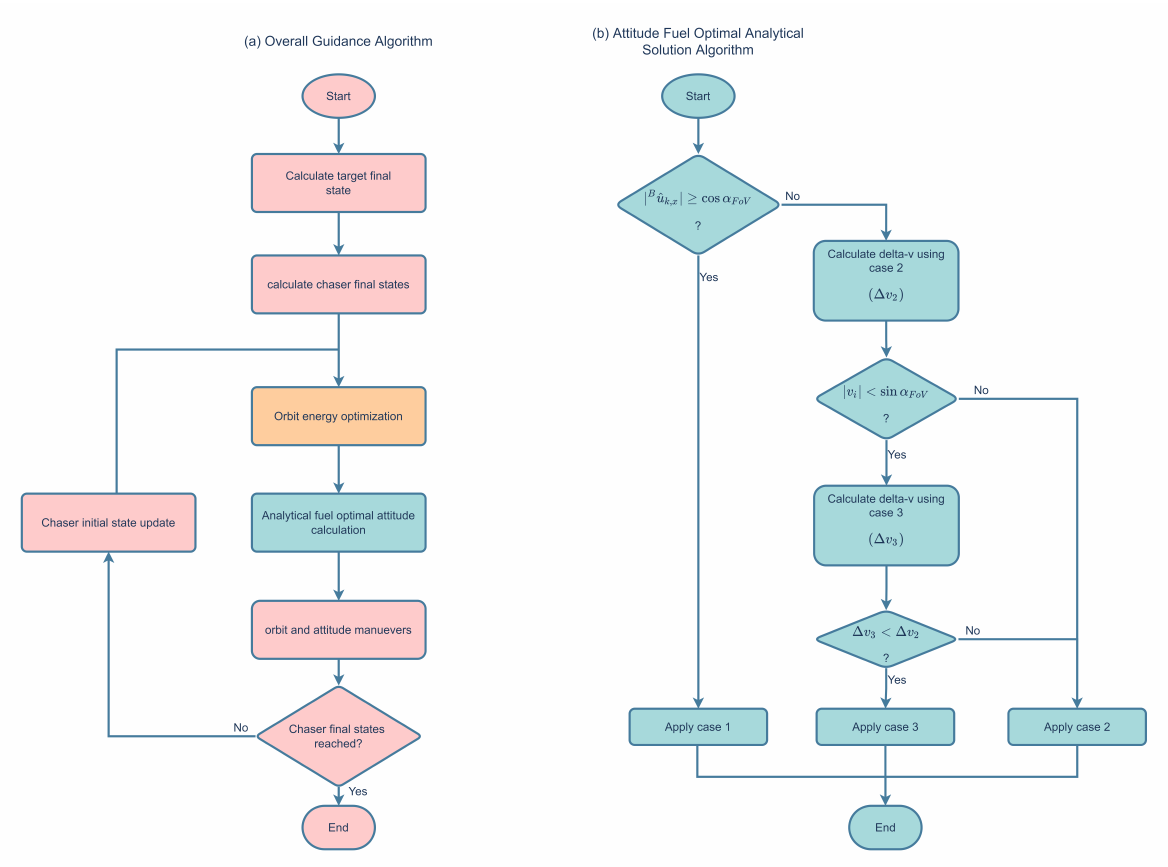
Figure 9. Guidance algorithm